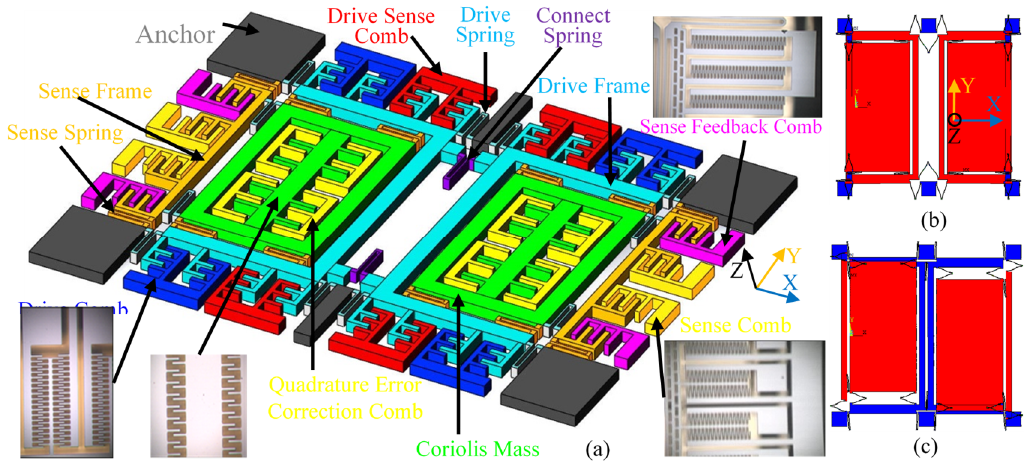
Figure 1. ( a ) Schematic and part photos of dual-mass gyroscope structure; ( b ) Simulation of drive anti-phase mode; ( c ) Simulation of sense anti-phase mode.